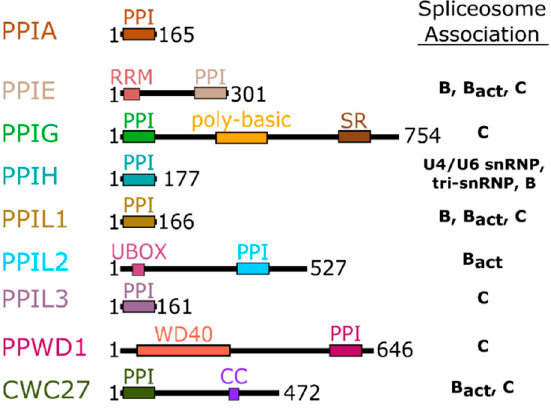
Figure 2. Domain organization of the nuclear cyclophilins. Colors are consistent throughout all figures. Spliceosome association is modified from [17,18] and is further shown in Figure 3.